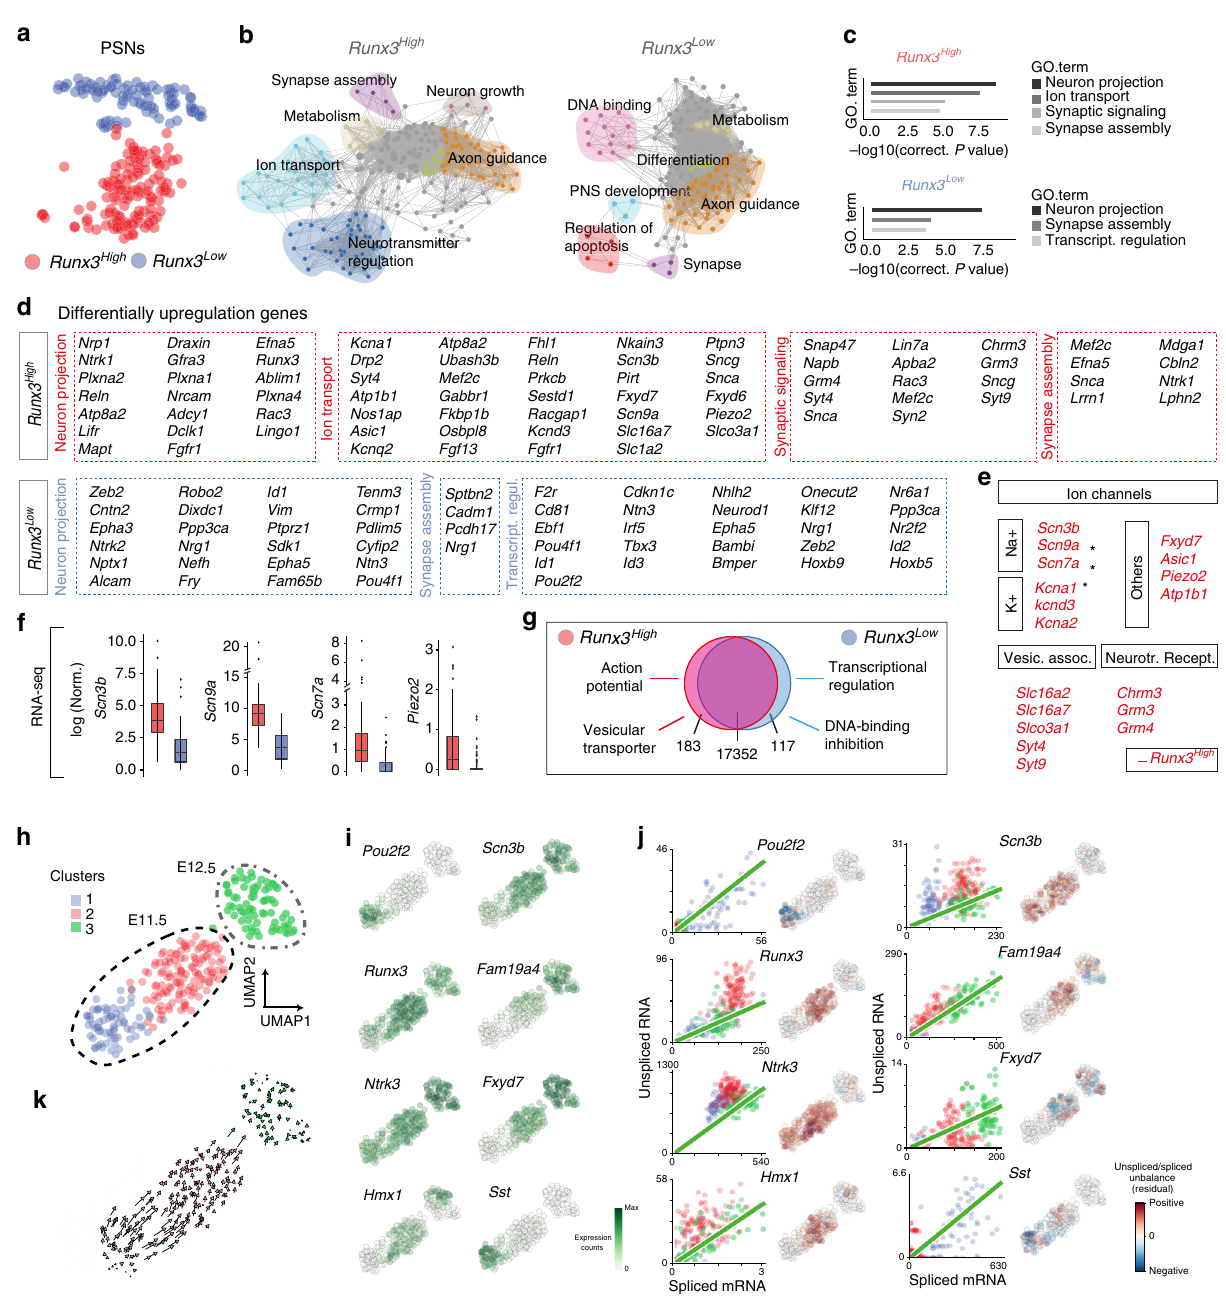
Fig. 5 Single-cell data identi fi es contrasted genetic signatures of neuronal maturation amongst PSNs subpopulations. a t -SNE plots representing the two groups of PSNs at E11.5 described in Fig. 4. b , c Gene set enrichment analysis of Runx3 High and Runx3 Low neurons visualized by network. Each node represents a GO term, edges are drawn when there are shared genes between two GO terms. Interestingly, the neurotransmission category is highly represented in the Runx3 High population while apoptosis and DNA-binding are more represented in the Runx3 Low population. c Gene ontology analysis of the Runx3 High (top panel) and Runx3 Low (bottom panel). The graph shows most signi fi cant terms re fl ecting neuronal features. d Examples of differentially expressed genes found in Runx3 High or Runx3 Low subpopulations of PSNs. e Expression of select genes that encode proteins relevant to neuronal physiology (asterisks depict genes important for the generation of action potentials). Note that this category of genes is uniquely over-represented in Runx3 High PSNs. f Expression of genes important for the generation a mature action potentials ( Scn3b / 7a / 9a ) and for mechanotransduction in PSNs (see text for details). Boxplots visualize the summary of the dataset (minimum, lower quartile, median, upper quartile and maximum). g Summary of the differential expression pro fi le of the two subpopulations of PSNs, with a majority of genes (17,352 genes) showing similar patterns; genes enriched in Runx3 High PSNs encode proteins associated with synaptic communication. h UMAP plot of PSNs single cells RNA-seq data from E11.5 and E12.5 (before and after cell death period, respectively), revealing two clusters at E11.5 (blue and red, corresponding to the clusters in a ) and only one cluster at E12.5 (green). i Expression pattern using UMAP plots with speci fi c Runx3 High and Runx3 Low marker genes shows that marker genes of E11.5 Runx3 High remain expressed at E12.5. j Unspliced – spliced phase portraits (left, cells colored according to a ) and u residuals (right) are shown for each gene in i . k Velocity estimates projected onto the two-dimensional UMAP plot of the dataset shown in h , and with a similar color code. Velocity vectors indicate positive velocity (strong directional fl ow) from one cell state to another and overall can be interpreted as a maturation directionality from Cluster 1 to Cluster 3. Source data are available as a Source Data fi